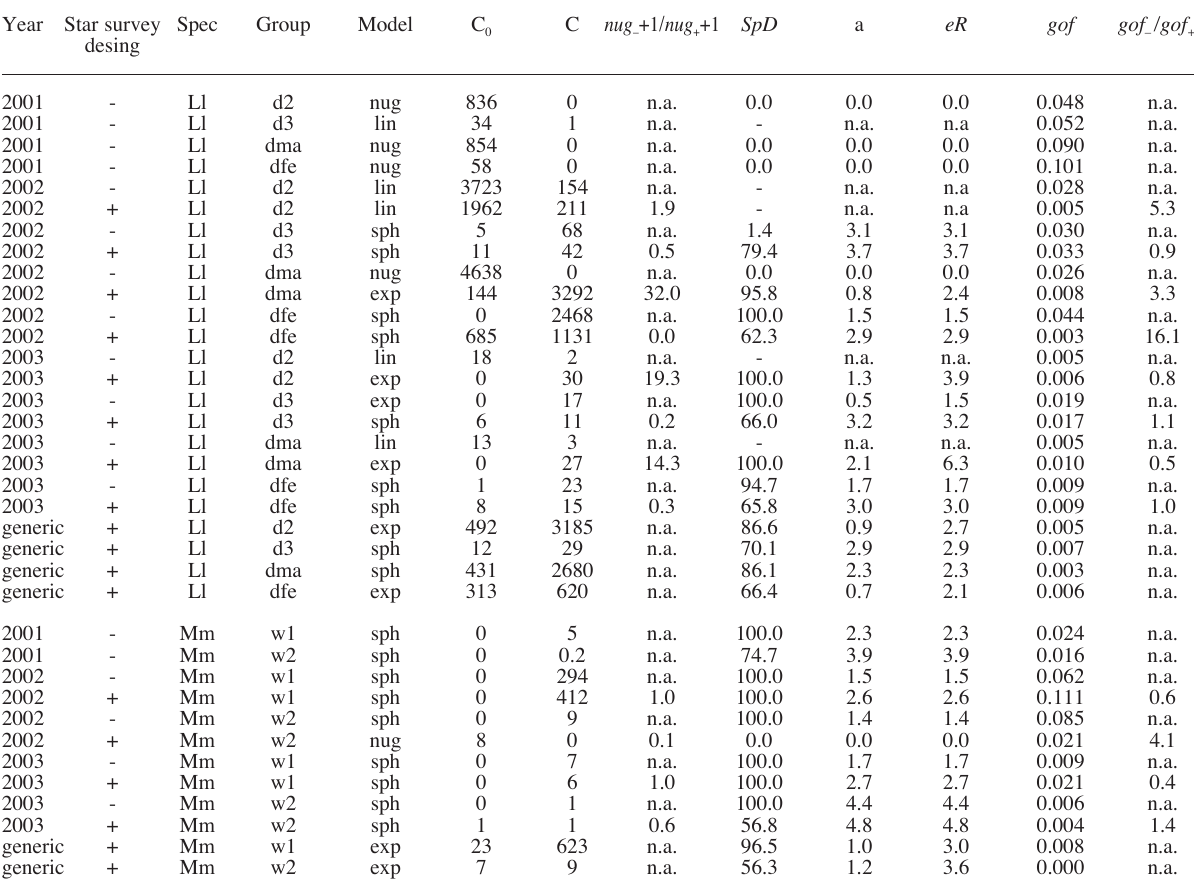
T ABLE 1. – Estimated parameters of spherical, exponential and linear semivariogram models fitted with a least-squares method to cpue data for dab and whiting in the German Bight (sampling area box A, Fig. 1). Ll: Limanda limanda (with size groups d2 and d3 and males, dma and females, dfe); Mm: Merlangius merlangus (with size groups w1 and w2); sph: spherical; exp: exponential; lin: linear; nug: pure nugget; C : nugget; C: sill (for linear models = slope); a: range (for exponential model effective range, eR =3a); SpD : spatial dependency (eq 5); gof : 0 measure of the goodness-of-fit (eq 4); nug +1/nug +1: ratios of nugget values without (-) and with (+) consideration of the star survey sta- - + / gof : ratios of goodness-of-fit values without (-) and with (+) consideration of the star survey stations; n.a.: not applicable (see tions; gof - + Methods section for